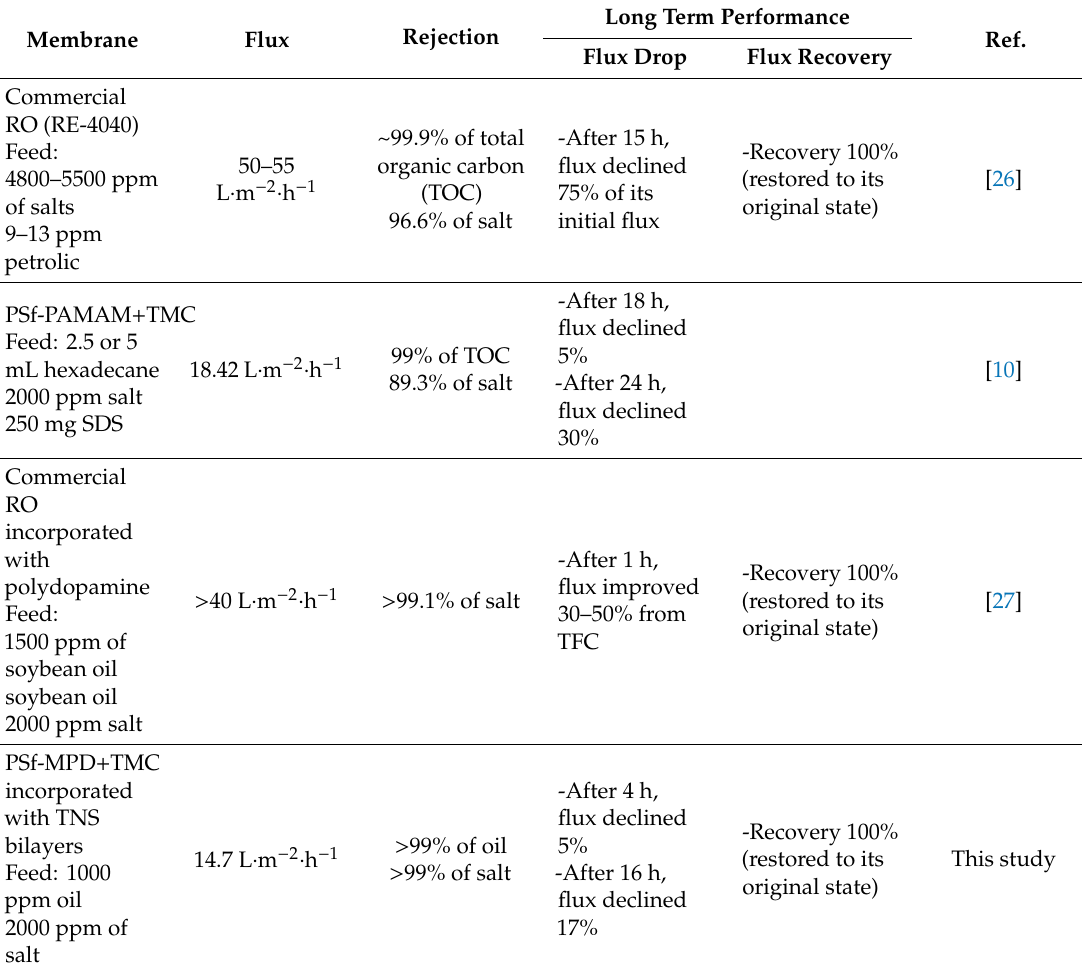
Table 3. Separation performance of reverse osmosis (RO) membranes towards produced water